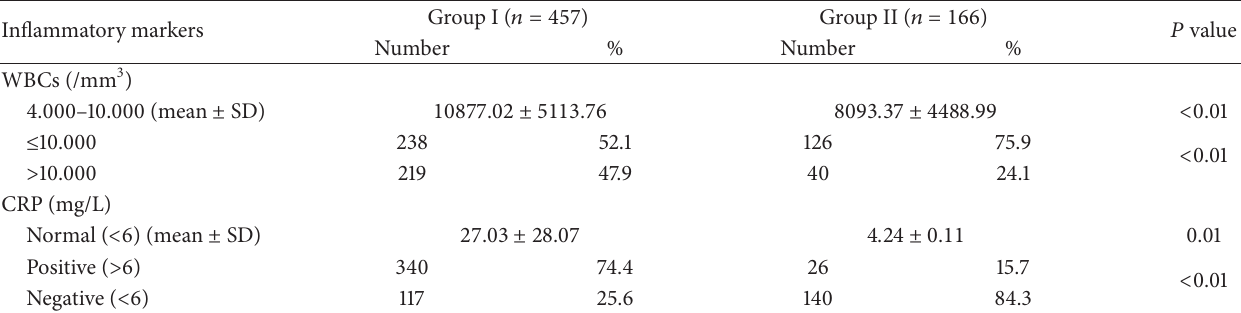
Table 4: Plasma inflammatory markers inbacterial and nonbacterial meningitis groups in the studied population. Inflammatory